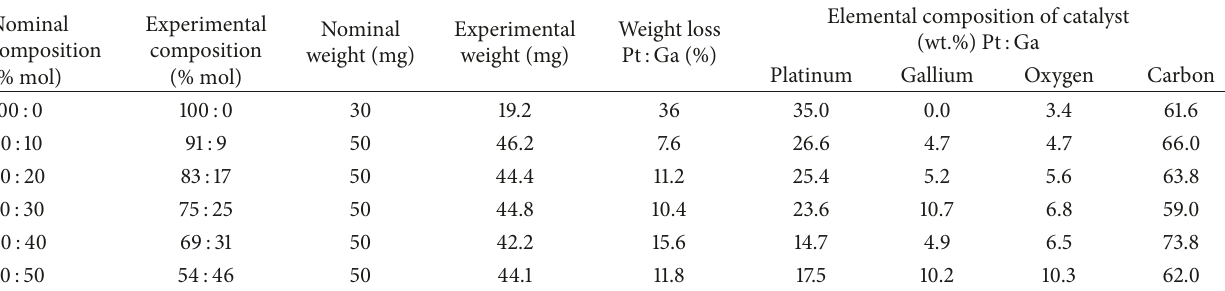
Table 1: EDX results and compositions of PtGa/C